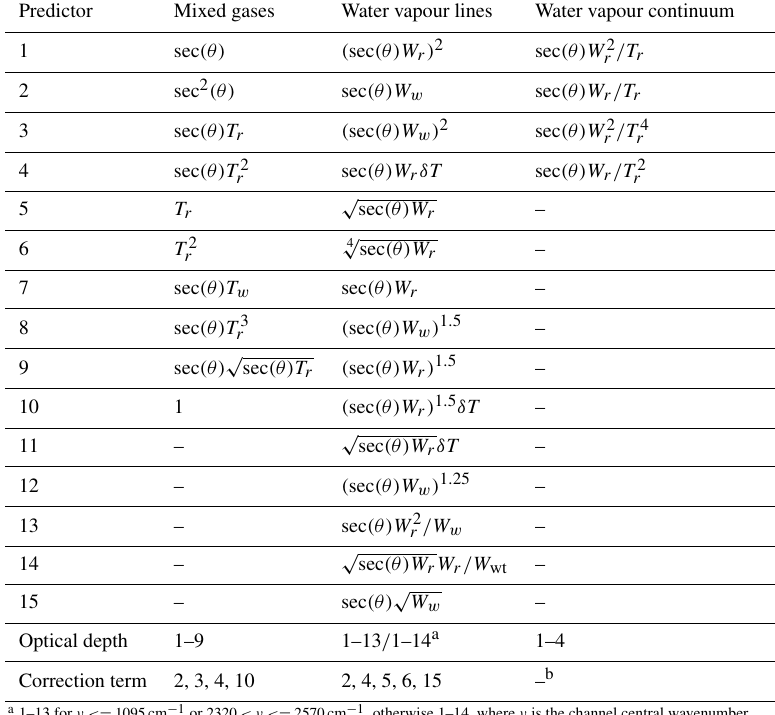
Table A2. Mixed gas and water vapour predictors and predictor lists for the optical depth and correction